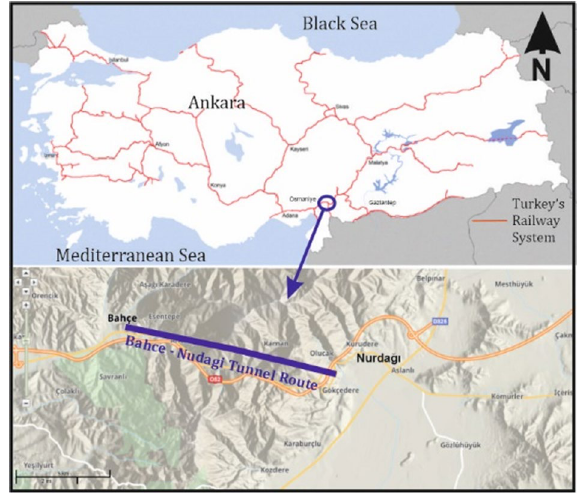
Fig. 1 Location map of the Bahce–Nurdag